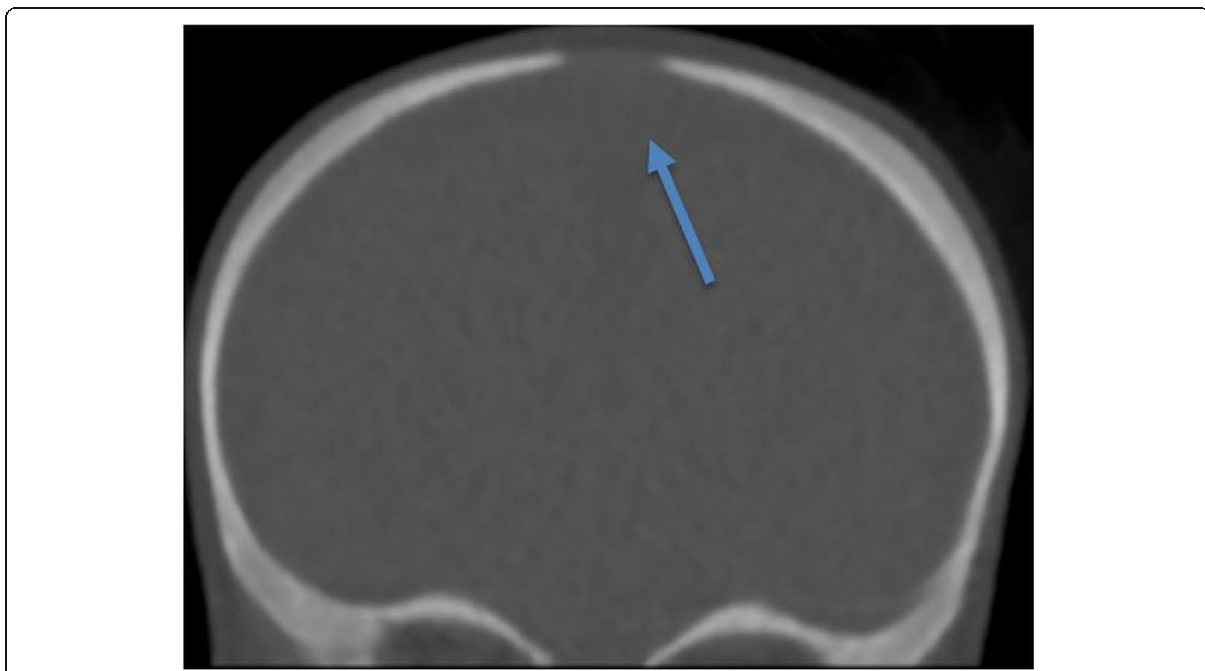
Fig. 5 Coronal head CT image (craniosynostosis protocol) of a 4-month-old male (7 kg) acquired at 1.5 mGy. Anterior fontanelle without evidence of craniosynostosis (arrow) and overall image quality scored optimal by all